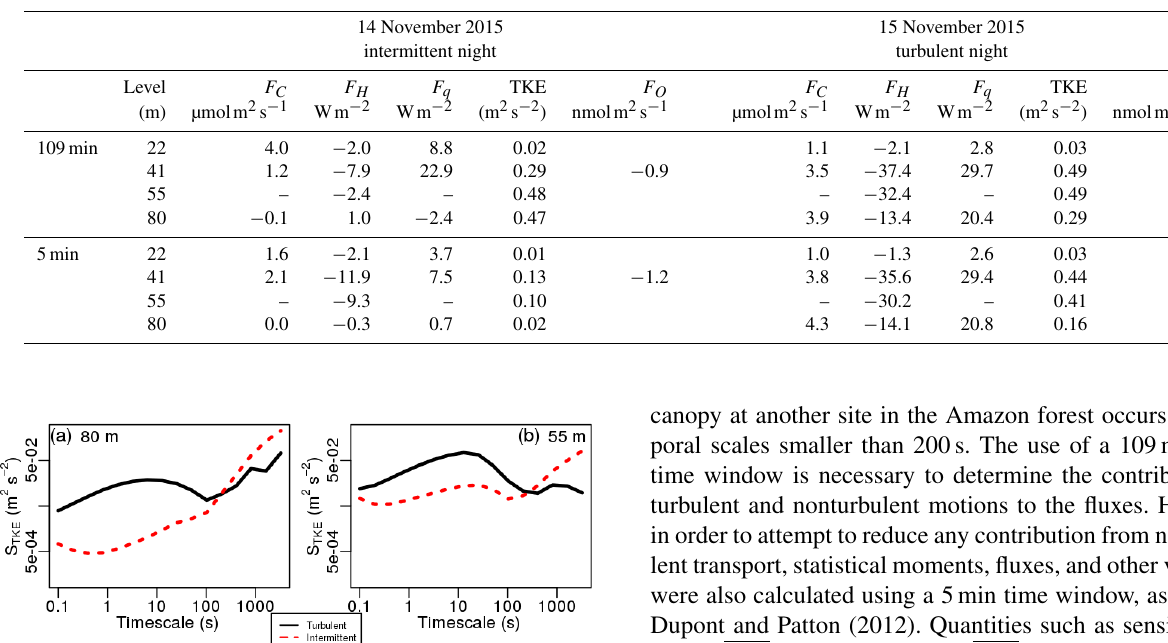
Table 3. TKE and fluxes averaged for each night analyzed in Sect. 3 using a time window of 5 and 109min.